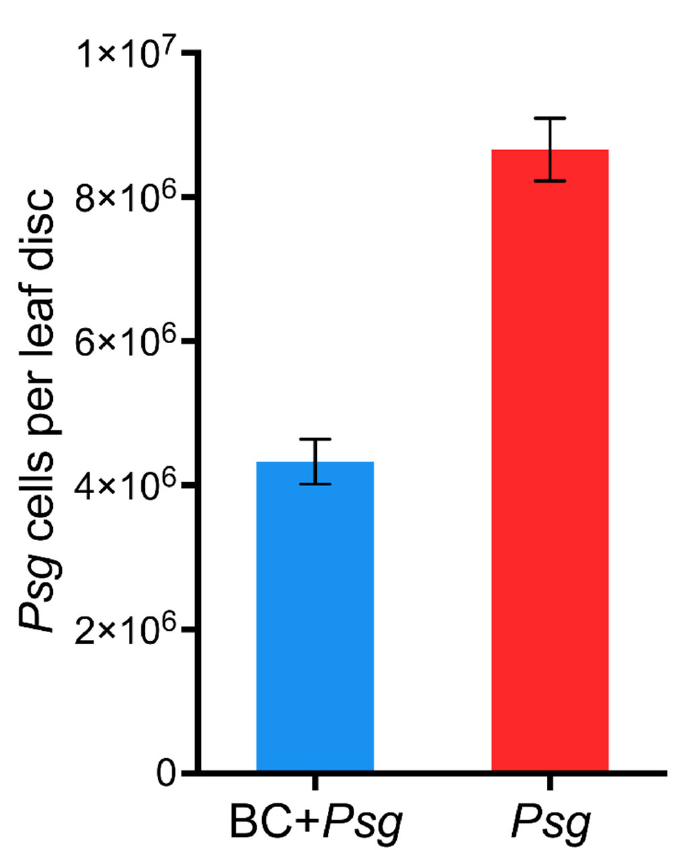
Figure 2. Quantification of Pseudomonas syringae pv. glycinea ( Psg ) cells per leaf disc in Psg and BC + Psg treatments on day 35 of plant growth. BC (bacterial consortia). The number of Psg cells per leaf disc was determined for twenty plants per treatment. Three leaves per plant was sampled and six leaf discs per plant were generated. The amount of Psg cells per leaf disc was significantly higher in the Psg treatment alone compared to the BC+ Psg treatment (F = 6.40; p < 0.016). The BC treatment added to uninfected plants had a significant positive effect on nodule fresh weight as compared to the control treatment (Figure 3C). The dry shoot weight, fresh nodule weight, and number of nodules in the BC + Psg treatment was not significantly different from the control (Figure 3A,C,D). The dry shoot weight, fresh nodule weight, and number of nodules were significantly lower in the Psg treatment than all other treatments (Figure 3A,C,D), thus confirming a negative effect of the